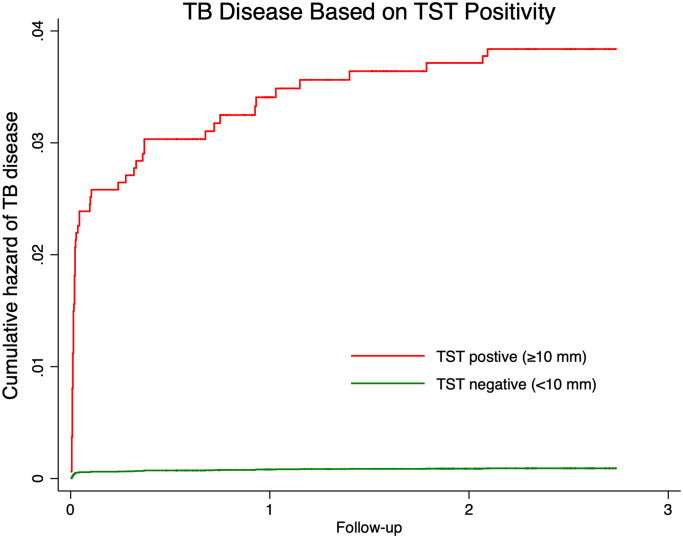
Cumulative hazard of TB disease based on TST positivity in children and adolescents from 2017 through 2019.TB, tuberculosis; TST, tuberculin skin testing.